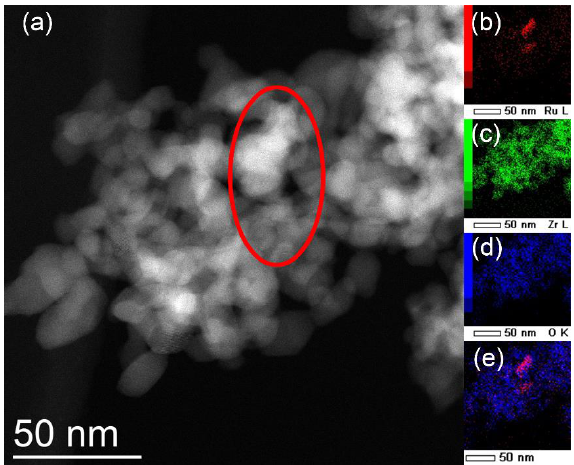
Figure 2. Results of STEM analysis of the fresh, thermally treated Ru / ZrO 2 catalyst: ( a ) STEM dark-field image, ( b – e ) energy-dispersive X-ray spectroscopy (EDS) mapping of Ru ( b ), Zr ( c ), O ( d ), and overlay display ( e ). The red ellipse indicates the area where Ru particles were identified in the EDS mapping.